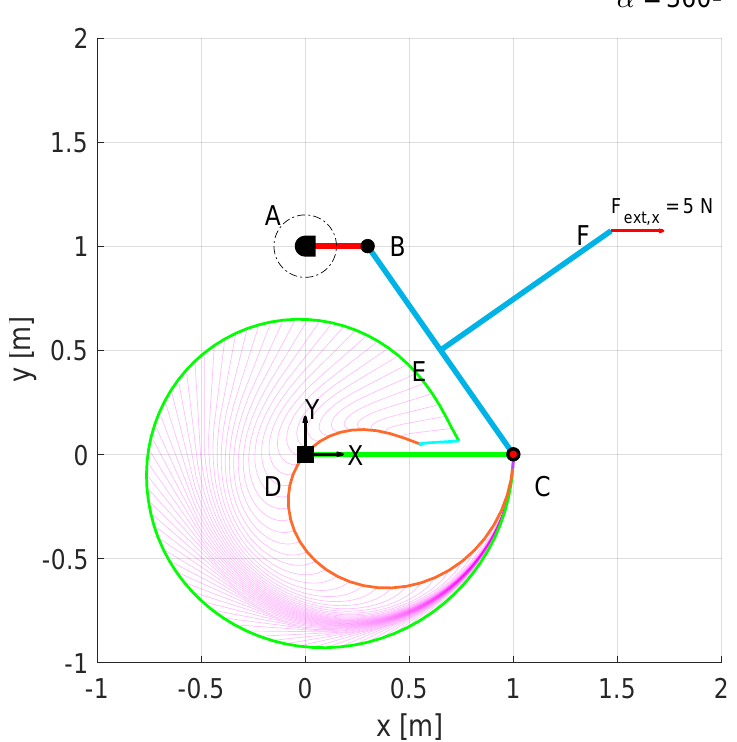
Figure 15. Cycle with buckling mode changes. Final